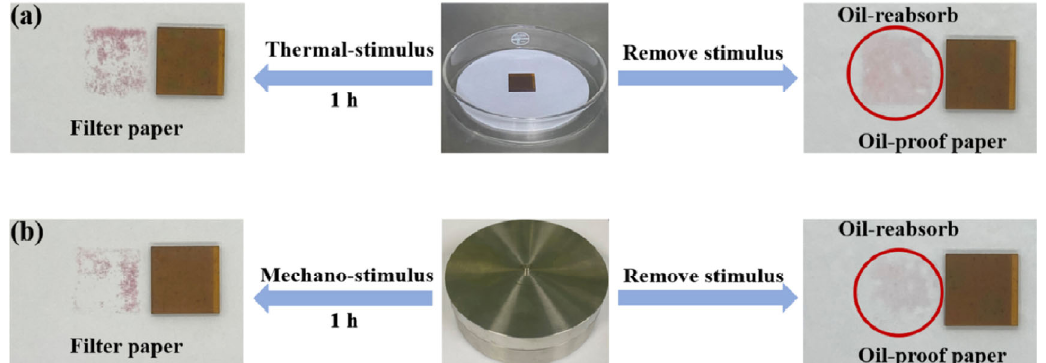
Fig. 13 Oil release of OCPI-T100 under (a) thermal-stimulus or (b) mechano-stimulus and capillary-force induced oil